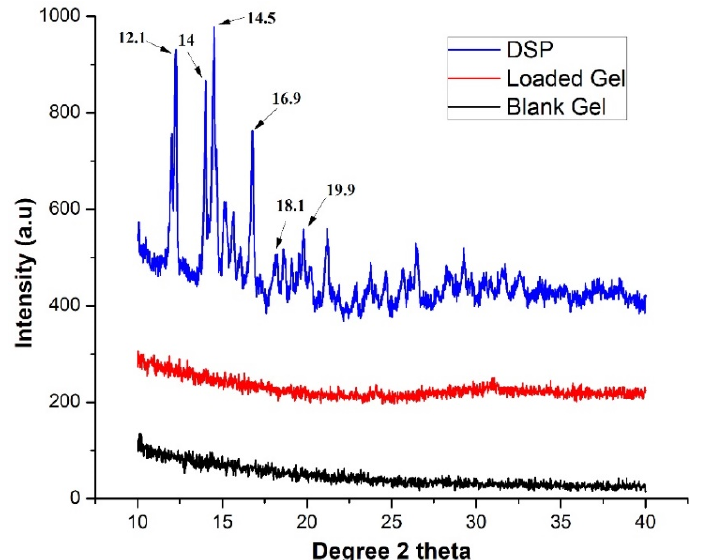
Figure 7. X-ray diffraction pattern of DSP, blank, and drug-loaded semi-IPN hydrogel matrices (AP-8).